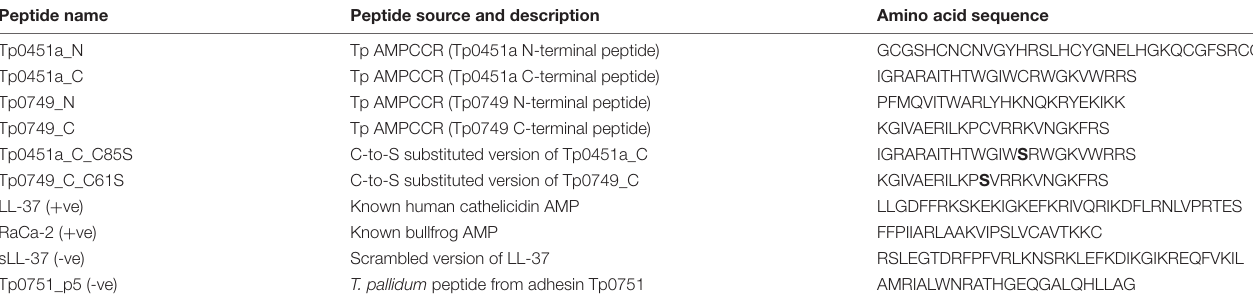
TABLE 1 | Chemically synthesized peptides used in the current